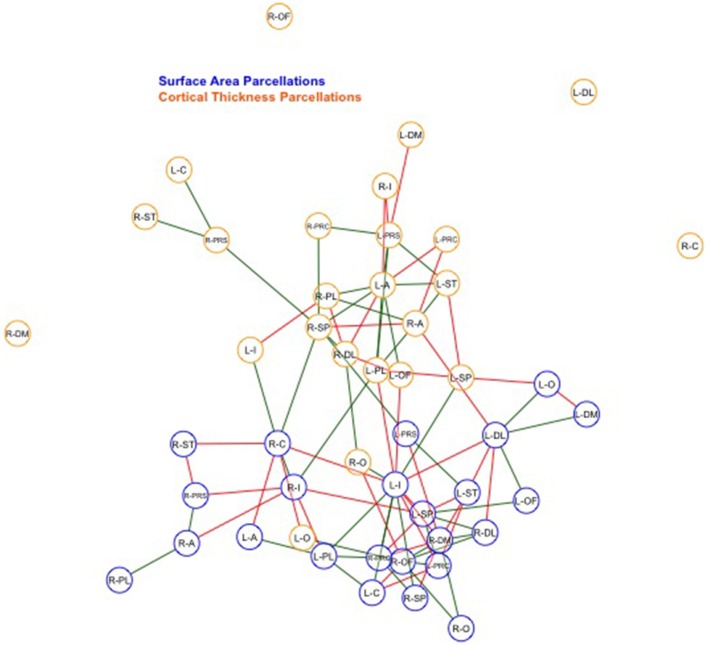
Above is a final network representation of genetic correlations where p < 0.05, and where the proximity of the edges denotes strength of genetic correlation between parcellations. Table 1 presents parcellation abbreviations for reference. Red edges reflect negative genetic correlations, and green edges reflect positive genetic correlations. SA parcellations are outlined in blue and CT cluster nodes are outlined in orange. R- and L-prefixes denote right and left hemispheric parcellations. Note increased edges stemming from right frontal SA, right central SA, and left medial CT. Two distinct local networks appear to surround the right frontal SA and left medial CT parcellations.